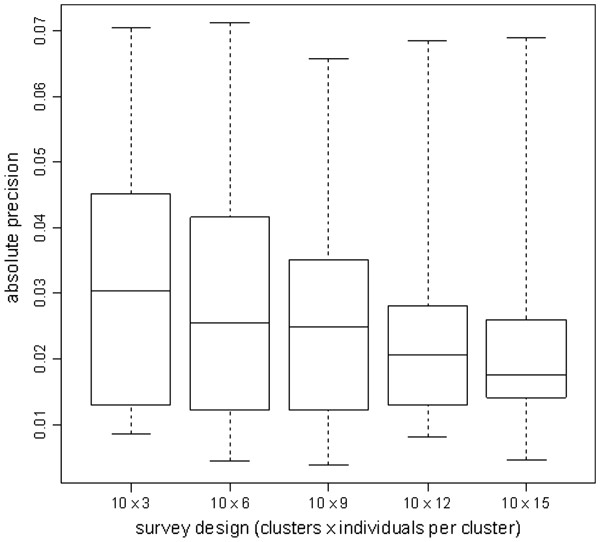
Absolute precision of estimates of the standard error of VC, for different survey designs. Box plots indicate the median and inter-quartile range of the median absolute precision values from 10 000 bootstrap replicates of each of the 41 stratum surveys. Whiskers denote the range.